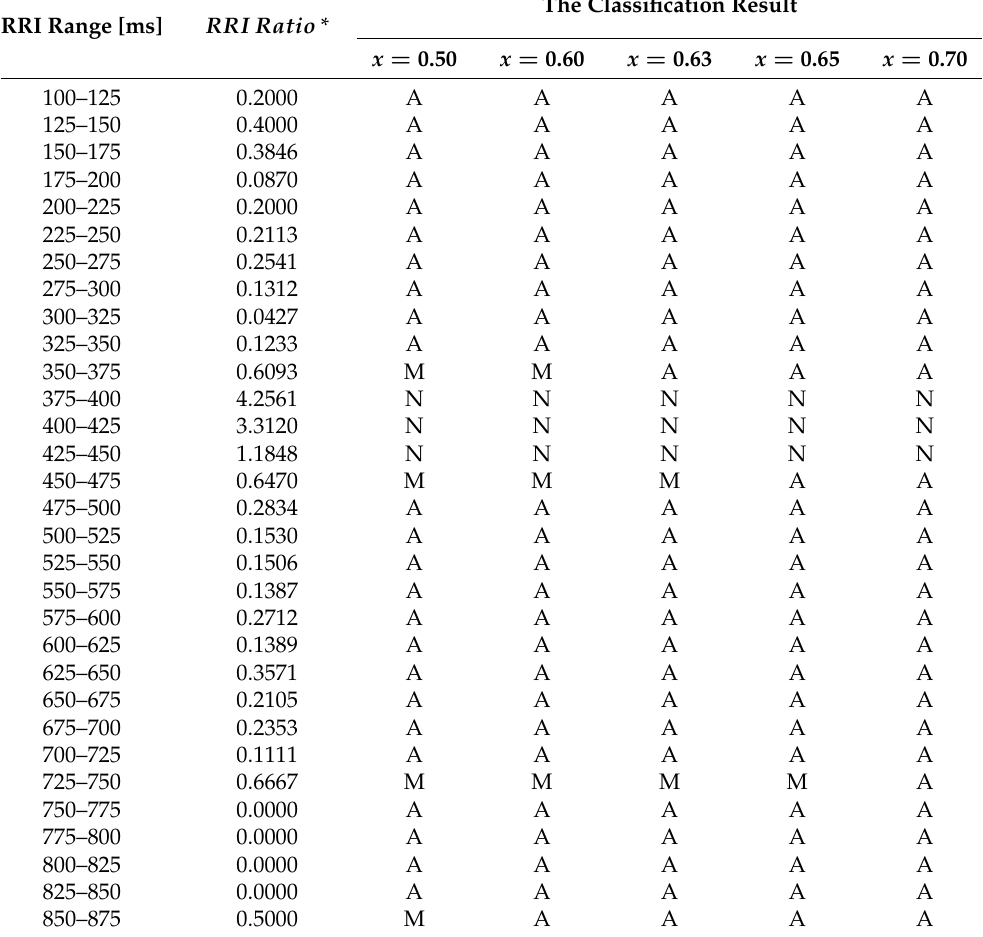
Table 2. The classification results of each RRI